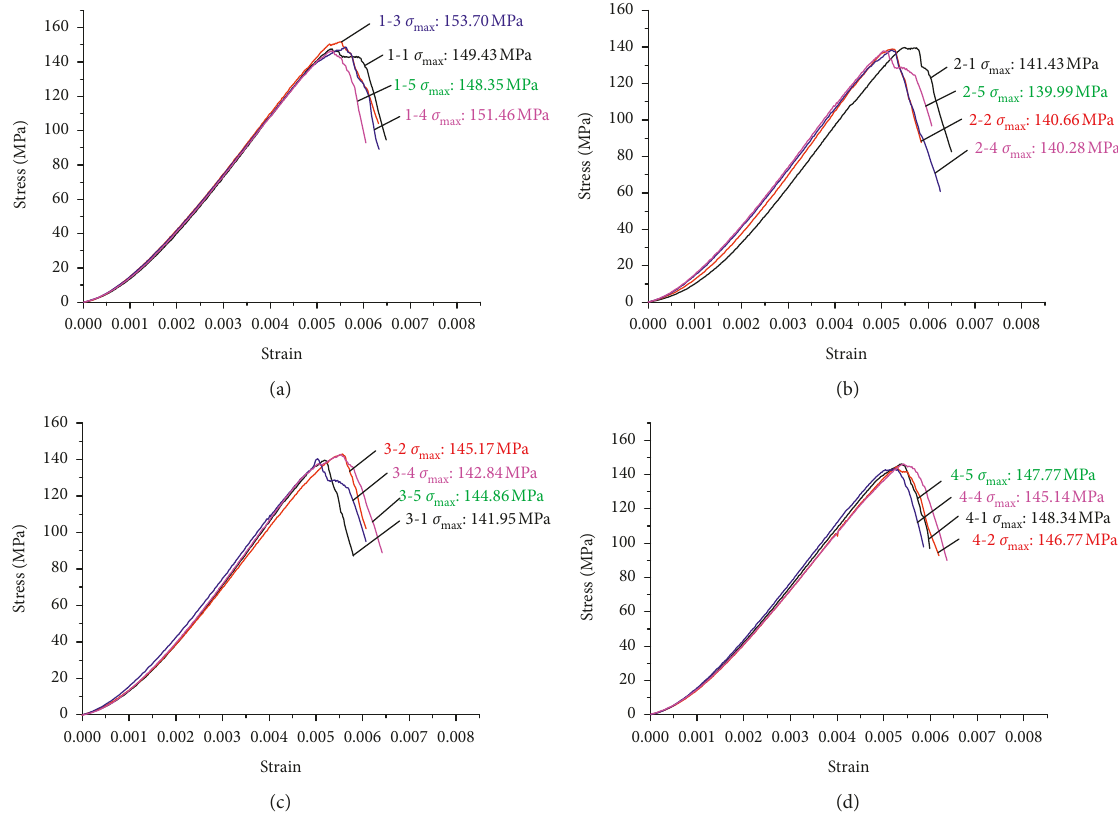
Figure 8: Stress-stain curves of granite specimen groups. (a) The first specimen group. (b) The second specimen group. (c) The third specimen group. (d) The fourth specimen group.